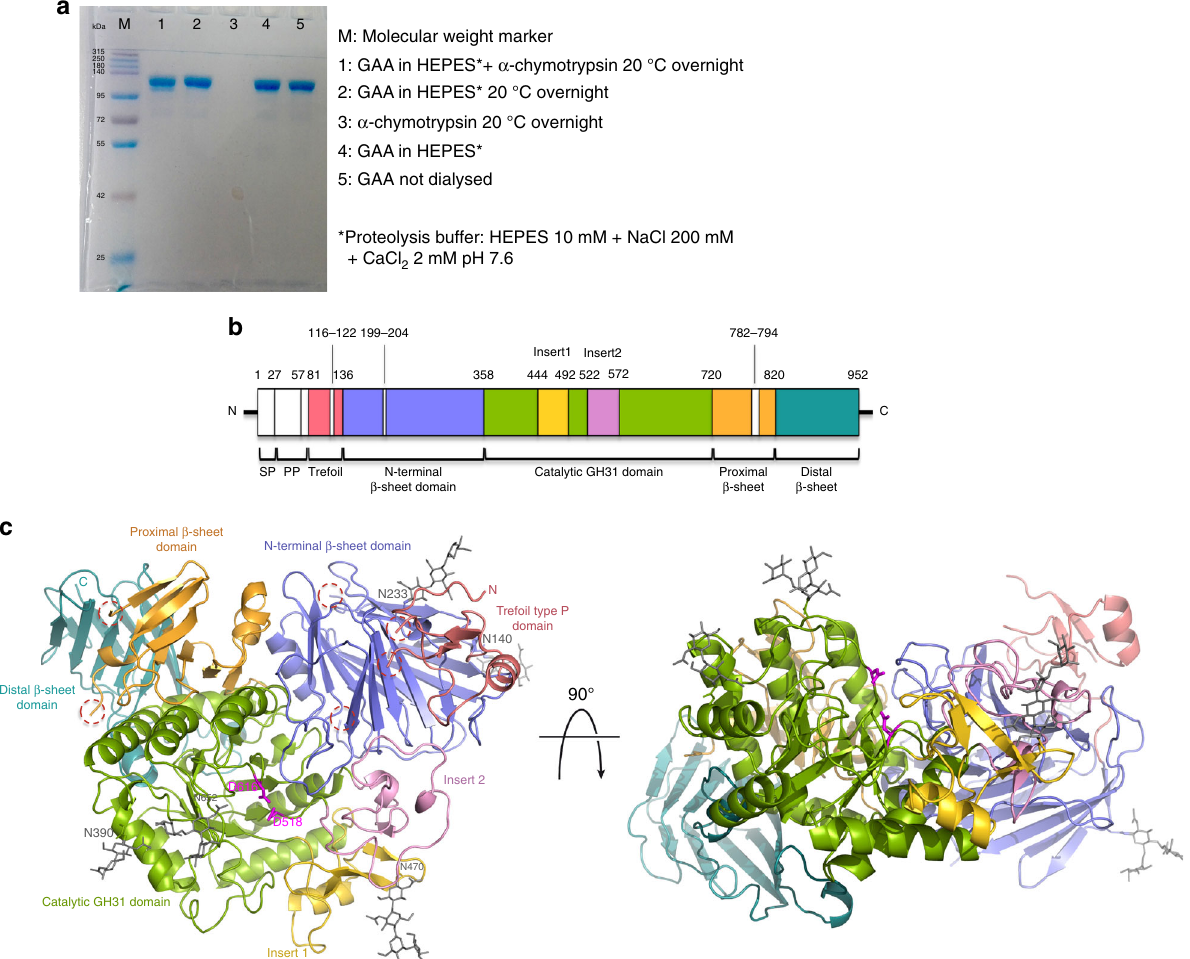
Fig. 2 Structure of mature rhGAA. a Proteolytic treatment of rhGAA. b Schematic representation of the sequence of GAA. Myozyme ® rhGAA used in ERT starts at residue Q57. Domains corresponding to the rhGAA structure are colored as in c , with the regions removed by treatment with α -chymotrypsin colored in white. c Cartoon representation of the structure of rhGAA consisting of the trefoil type-P domain (salmon), the N-terminal β -sheet domain (slate), the catalytic GH31 ( β / α ) 8 barrel domain (green) with insert I (gold) and insert II (pink), and the proximal (orange) and distal (teal) β -sheet domains. Catalytic residues (magenta) and glycan chains (grey) are depicted as sticks. Dashed lined circles highlight peptide portions removed by proteolysis with α -chymotrypsin before crystallization. (SP, signal peptide; PP,